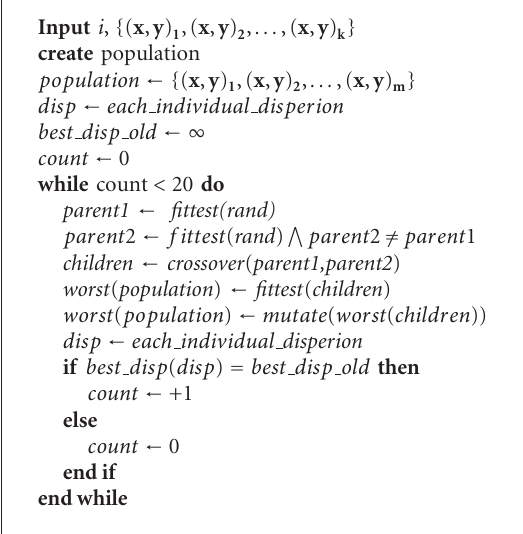
Algorithm 4: Genetic Algorithm (GA) for clustering.